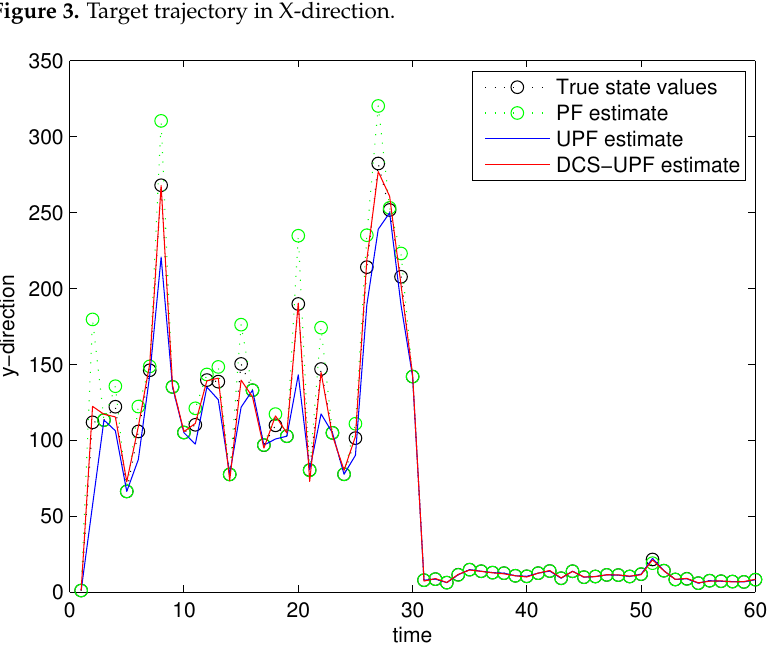
Figure 4. Target trajectory in